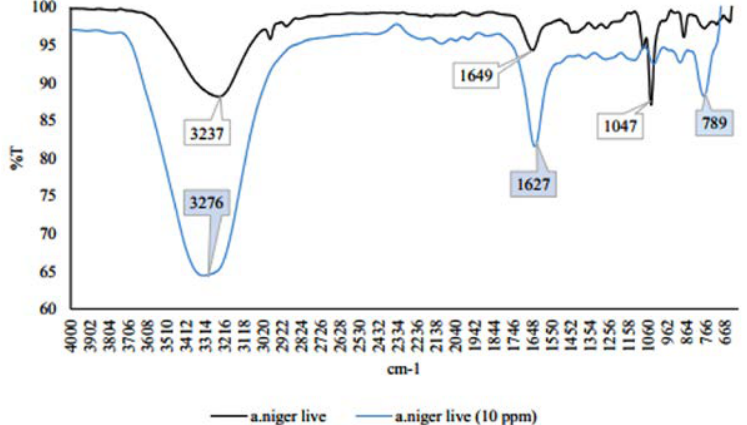
Fig. 6 . FTIR data of live cells of A. niger before and after the absorption in 10 ppm Hg 2+